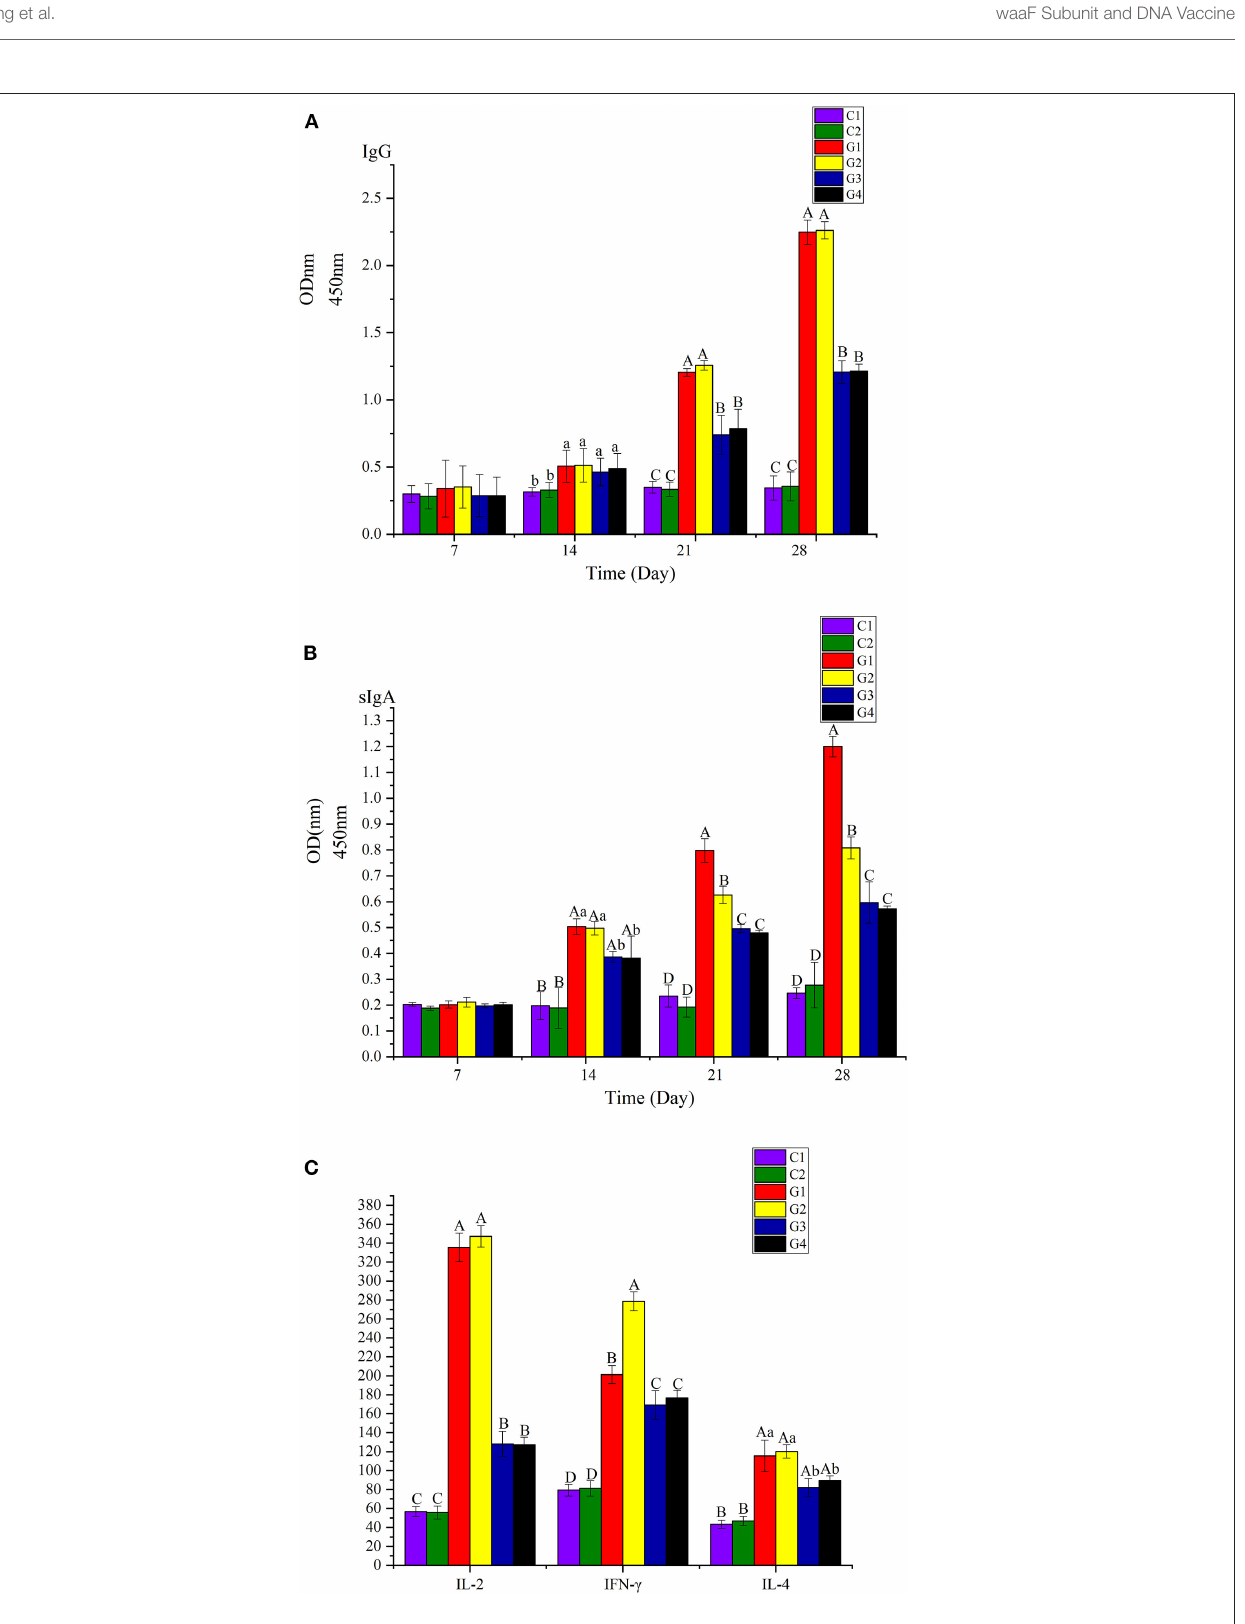
FIGURE 5 | (A) Analyzed the IgG on the 7th, 14th, 21th, and 28th days. (B) Analyzed the sIgA of feces on the 7th, 14th, 21th, and 28th days. (C) Analyzed the IL-2, IL-4, and IFN- γ of serum on the 28th day. The difference between different capital letters is extremely significant ( p < 0.01), and the significant differences between different lowercase letters ( p <